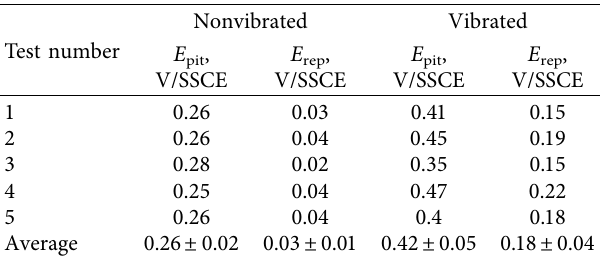
Figure 2: Potentiodynamic sweep of AISI 316 stainless steel in 3.5% NaCl solution. 1: nonvibrated; 2: vibrated. Sweep rate: 0.2mV/s. Ultrasound parameters: frequency 27kHz, power 10 W. Table 1: The pitting potential E pit and repassivation potential E rep of the AISI 316 steel in 3.5% NaCl in vibrated and nonvibrated